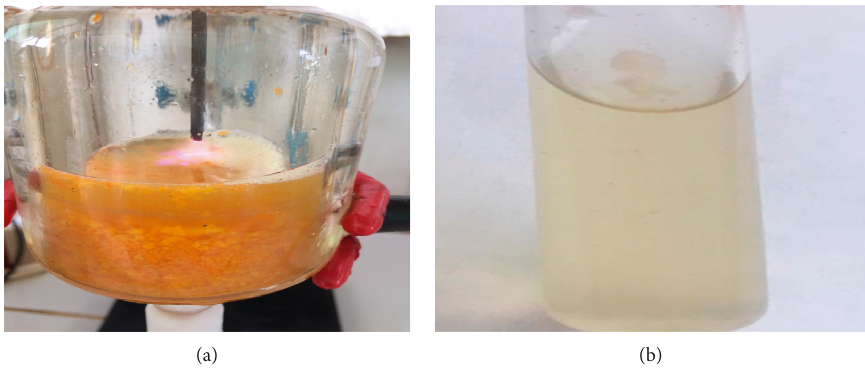
Figure 1: Plasmochemical treatment of dry orange peel powder ( a ) and plasmochemically obtained grape pomace water extract after filtration